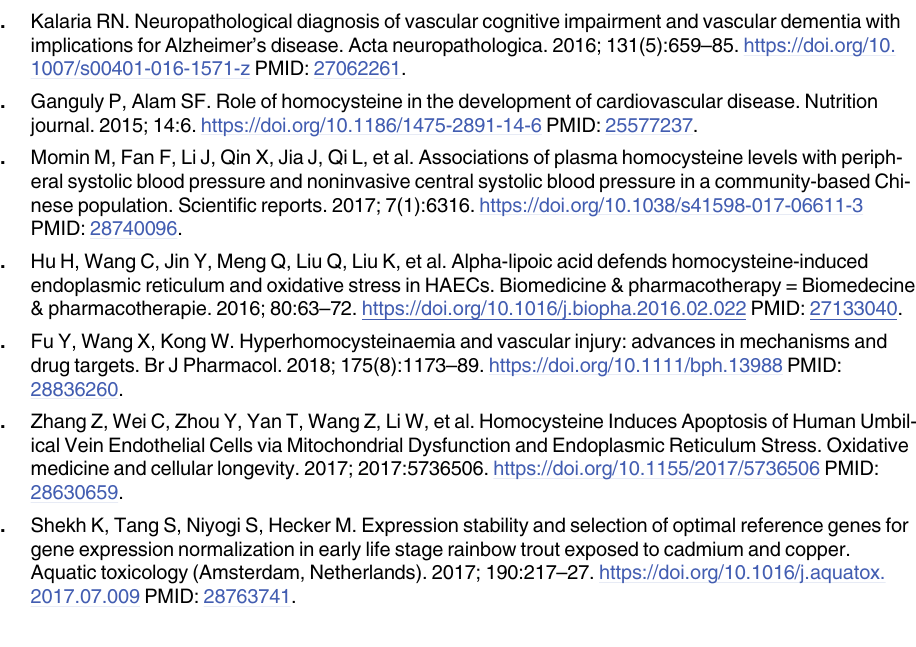
S1 Fig. The full uncropped and un-altered blot image of ACTB. (TIF) S2 Fig. The full uncropped and un-altered blot image of GAPDH.